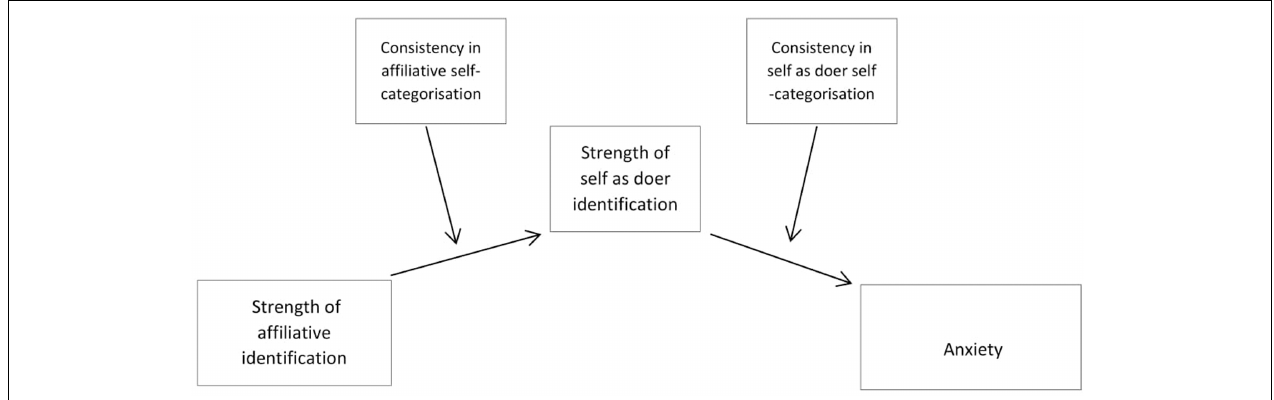
FIGURE 1 | Hypothetical model of relationships between identification, consistency, and